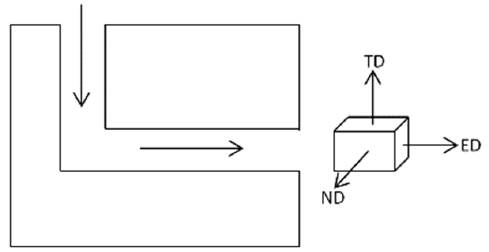
Figure 1. Mutual orientation of the equal-channel angular pressing (ECAP) die and the billet.